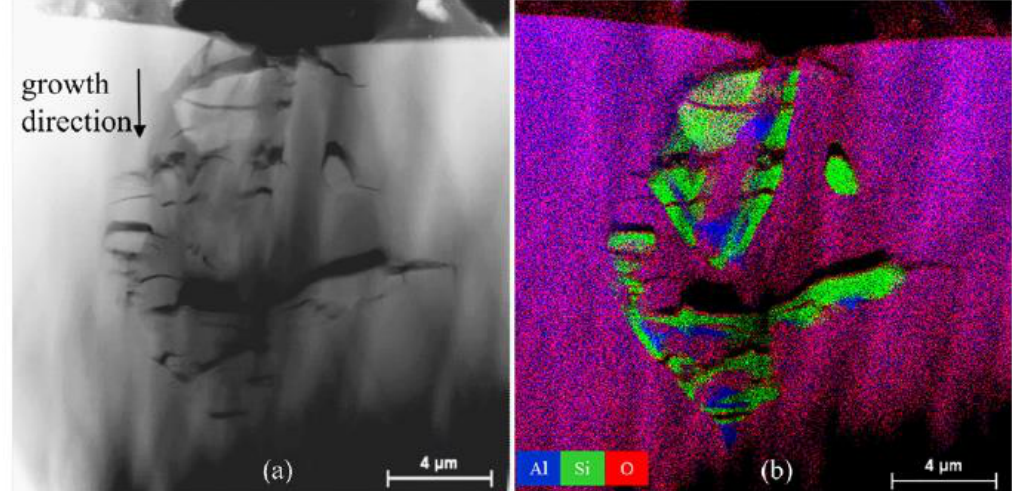
Figure 17. STEM-EDXS micrographs of the anodized layer containing Si flakes (alloy C): ( a ) STEM micrograph; ( b ) EDXS elemental map. Reprinted with permission of [99].